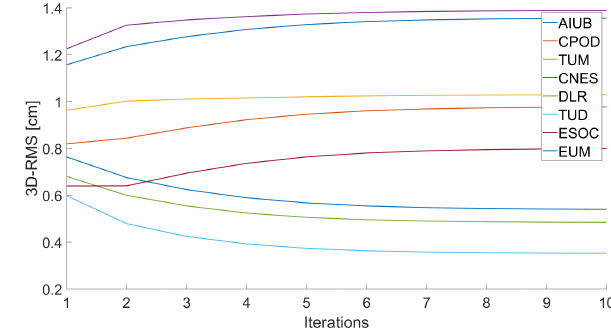
Figure 9. RMS of solutions as a function of number of iterations.